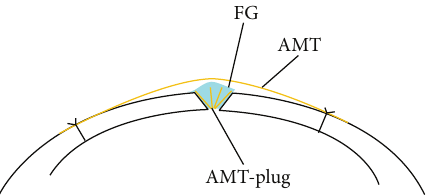
Figure 2: Scheme of the technique. The FG-assisted AMT-plug is in the defect with a new FG to stabilize it and amniotic membrane patch overlaid. AMT, amniotic membrane transplant; FG, fibrin